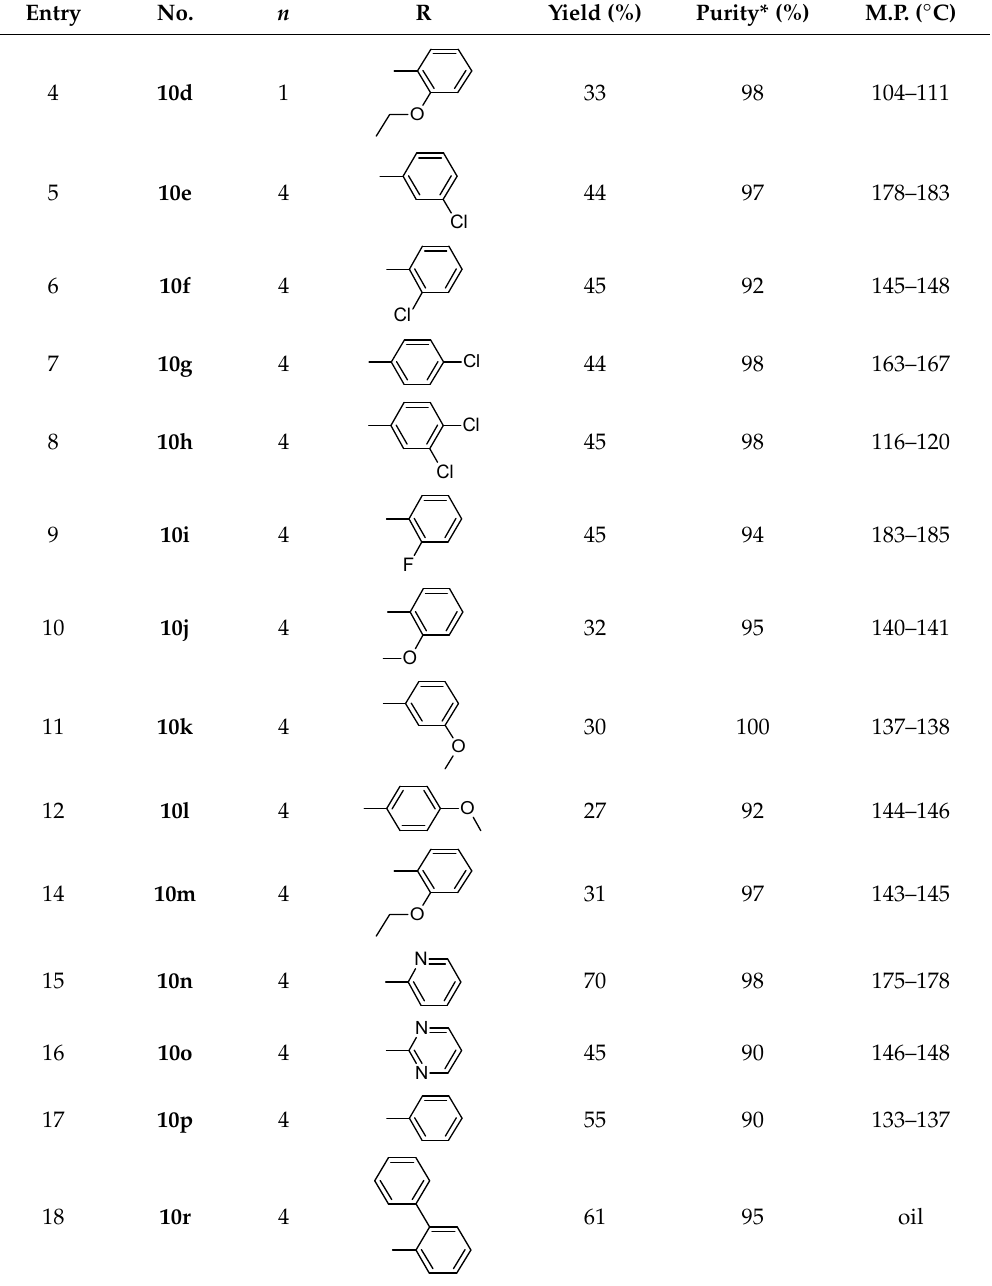
Table 5. Analytical data of the library 10a – 10k. M.P.—melting